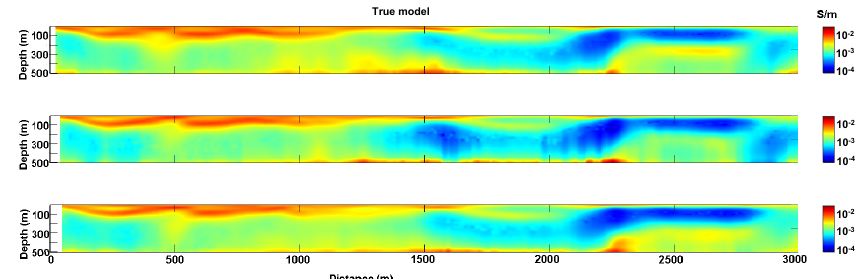
Figure 2. The verification dataset. The individual 1D conductivity models of these sections have been used to generate the noise-free synthetic data to be subsequently inverted with the Artificial Neural Networks (ANN) discussed in the section “Methods”.